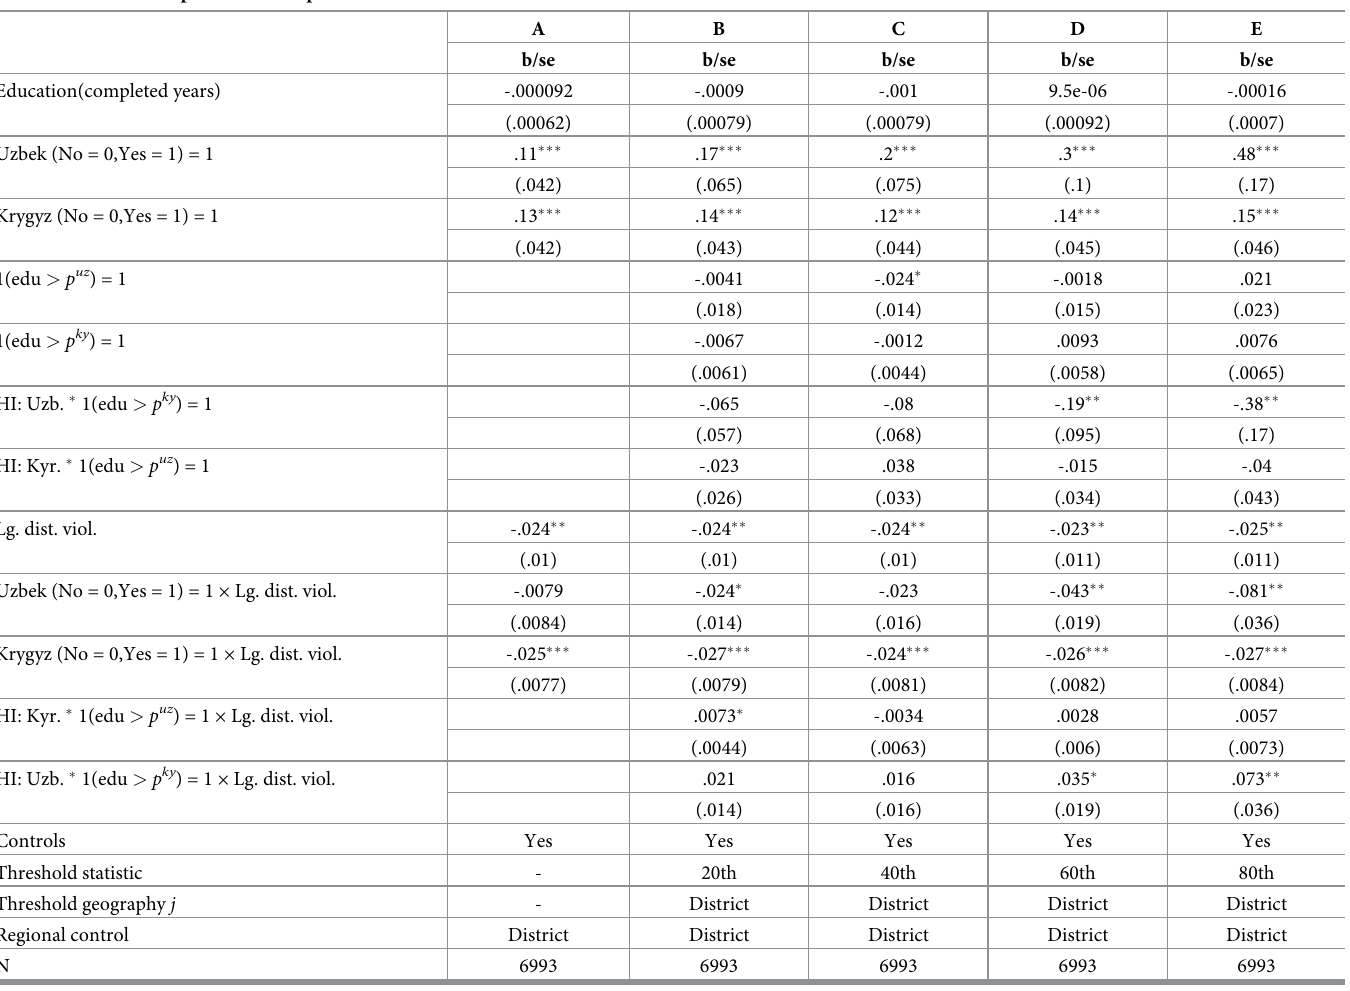
Table 8. Individual displacement and